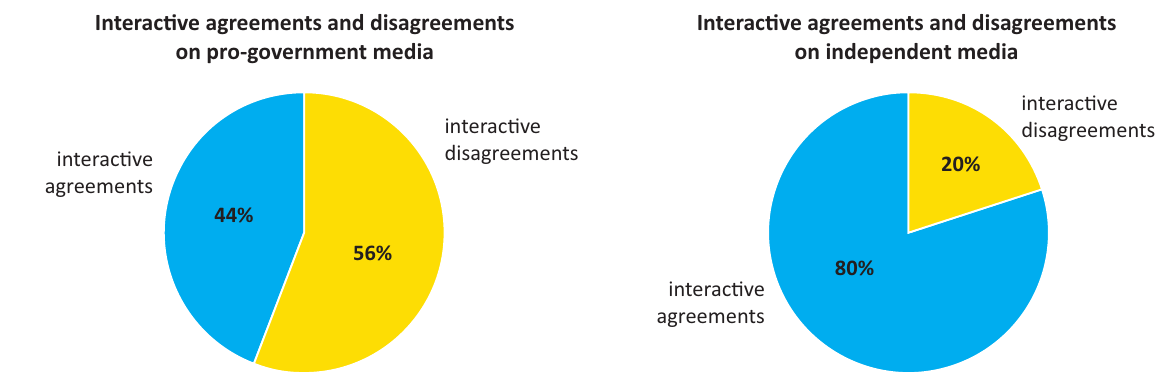
Figure 5. Interactive agreements and disagreements on pro-government and independent media.